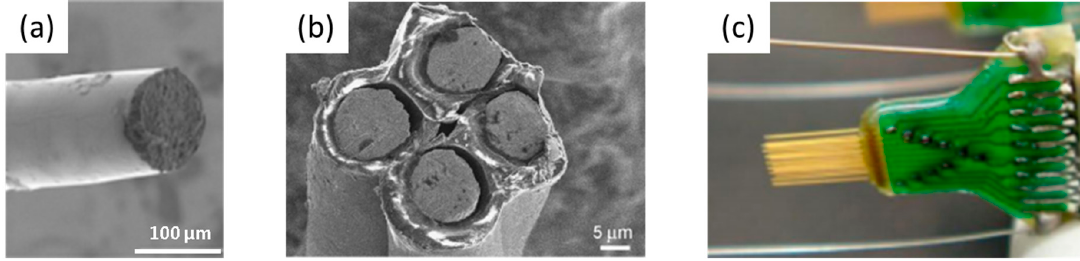
Figure 3. The types of microwire neural electrode ( a ) single wire [38], Copyright 2017, Elsevier; ( b ) Tetrode [39], Copyright 2017, Elsevier; ( c ) multi-wire electrode [40], Copyright 2010, Frontiers.